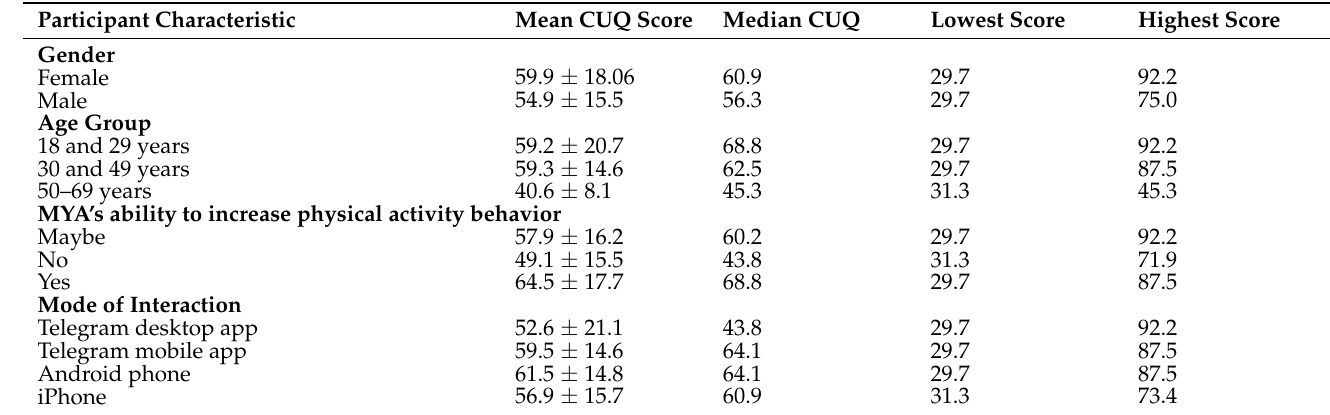
Table 3. Chatbot Usability Questionnaire (CUQ) Scores for study participants ( n = 30) according to participant